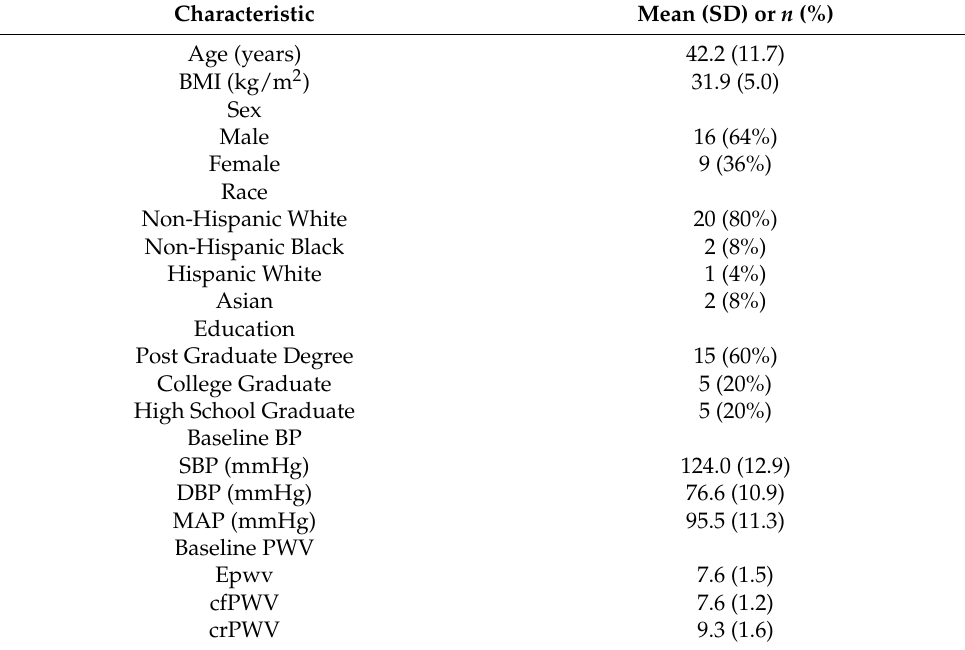
Table 1. Participant characteristics ( n =